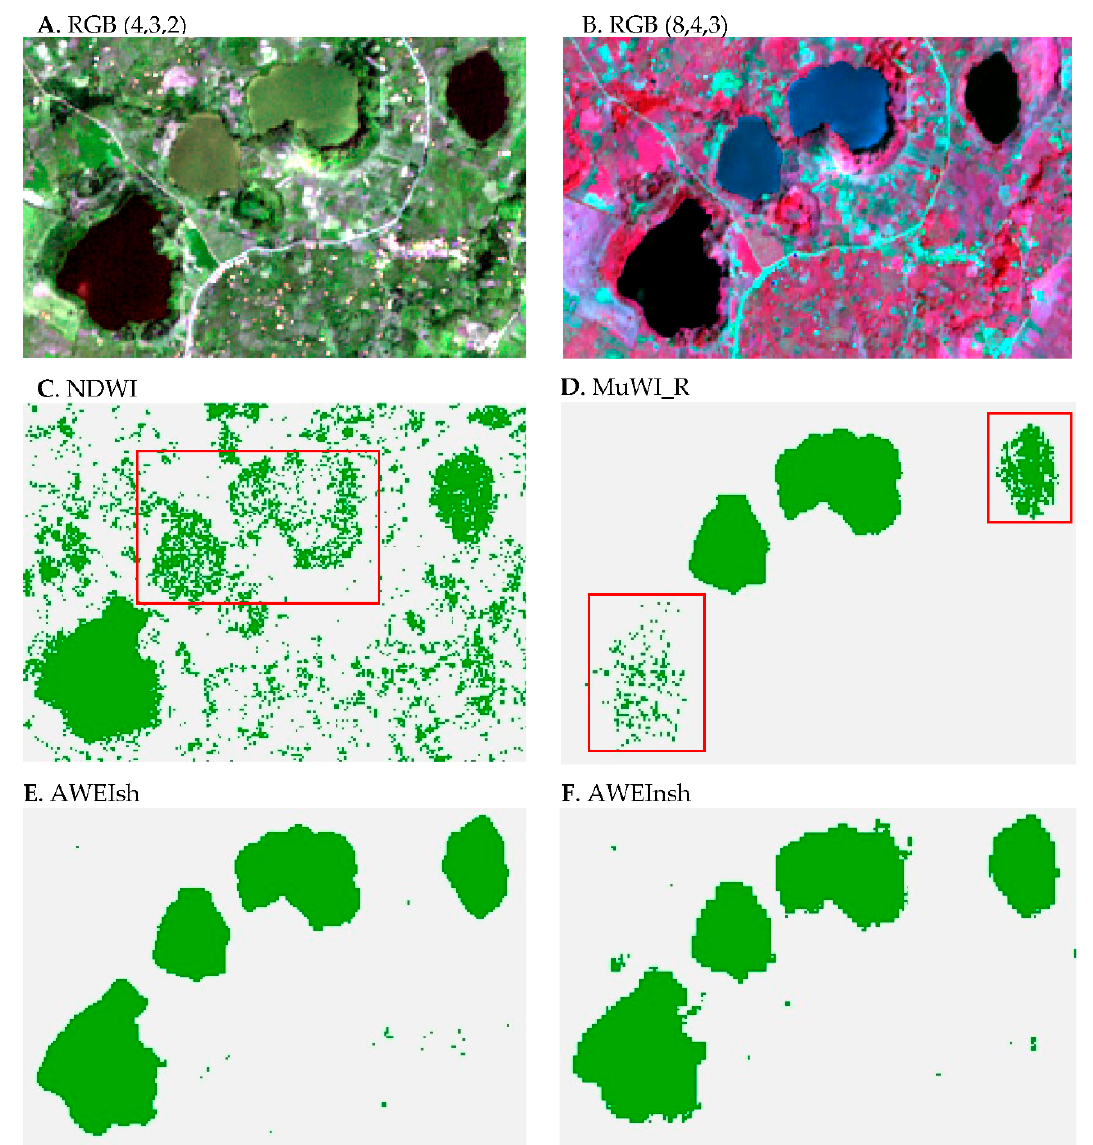
Figure 4. Comparing cases of crater lake extraction from site 2. Frame ( A ) is Sentinel-2 MSI RGB (4,3,2) 10 m natural-color image, Frame ( B ) is Sentinel-2 MSI RGB (8,4,3) false-color composite. In frames ( C – F ), green is water while grey is non- water. Frame ( C ) shows results of NDWI where some crater lakes were omitted (red rectangle) and background noise is misclassified as water, ( D ) is MuWI_R which misclassified two crater lakes (red rectangles) but effectively eliminated the background noise, ( E , F ) are AWEIsh and AWEInsh, respectively which effectively extracted the crater lakes and eliminated non-water background noise.